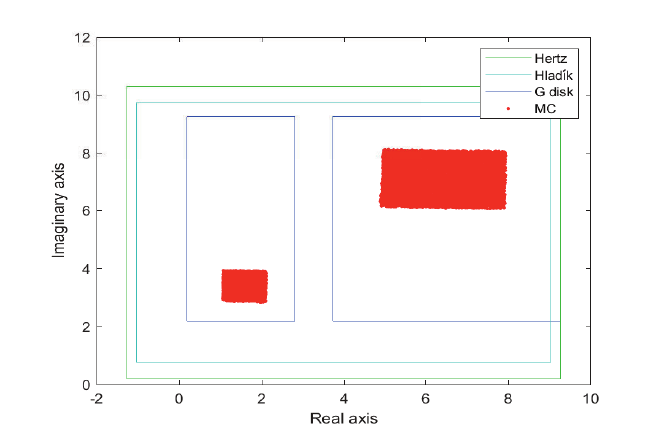
Fig. 3. Eigenvalue set and enclosures of Example 3.